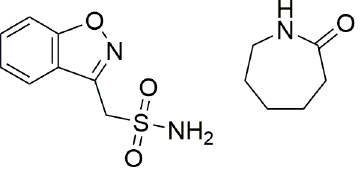
Figure 1. Zonisamide and ϵ -caprolactam, components of the title cocrystal.